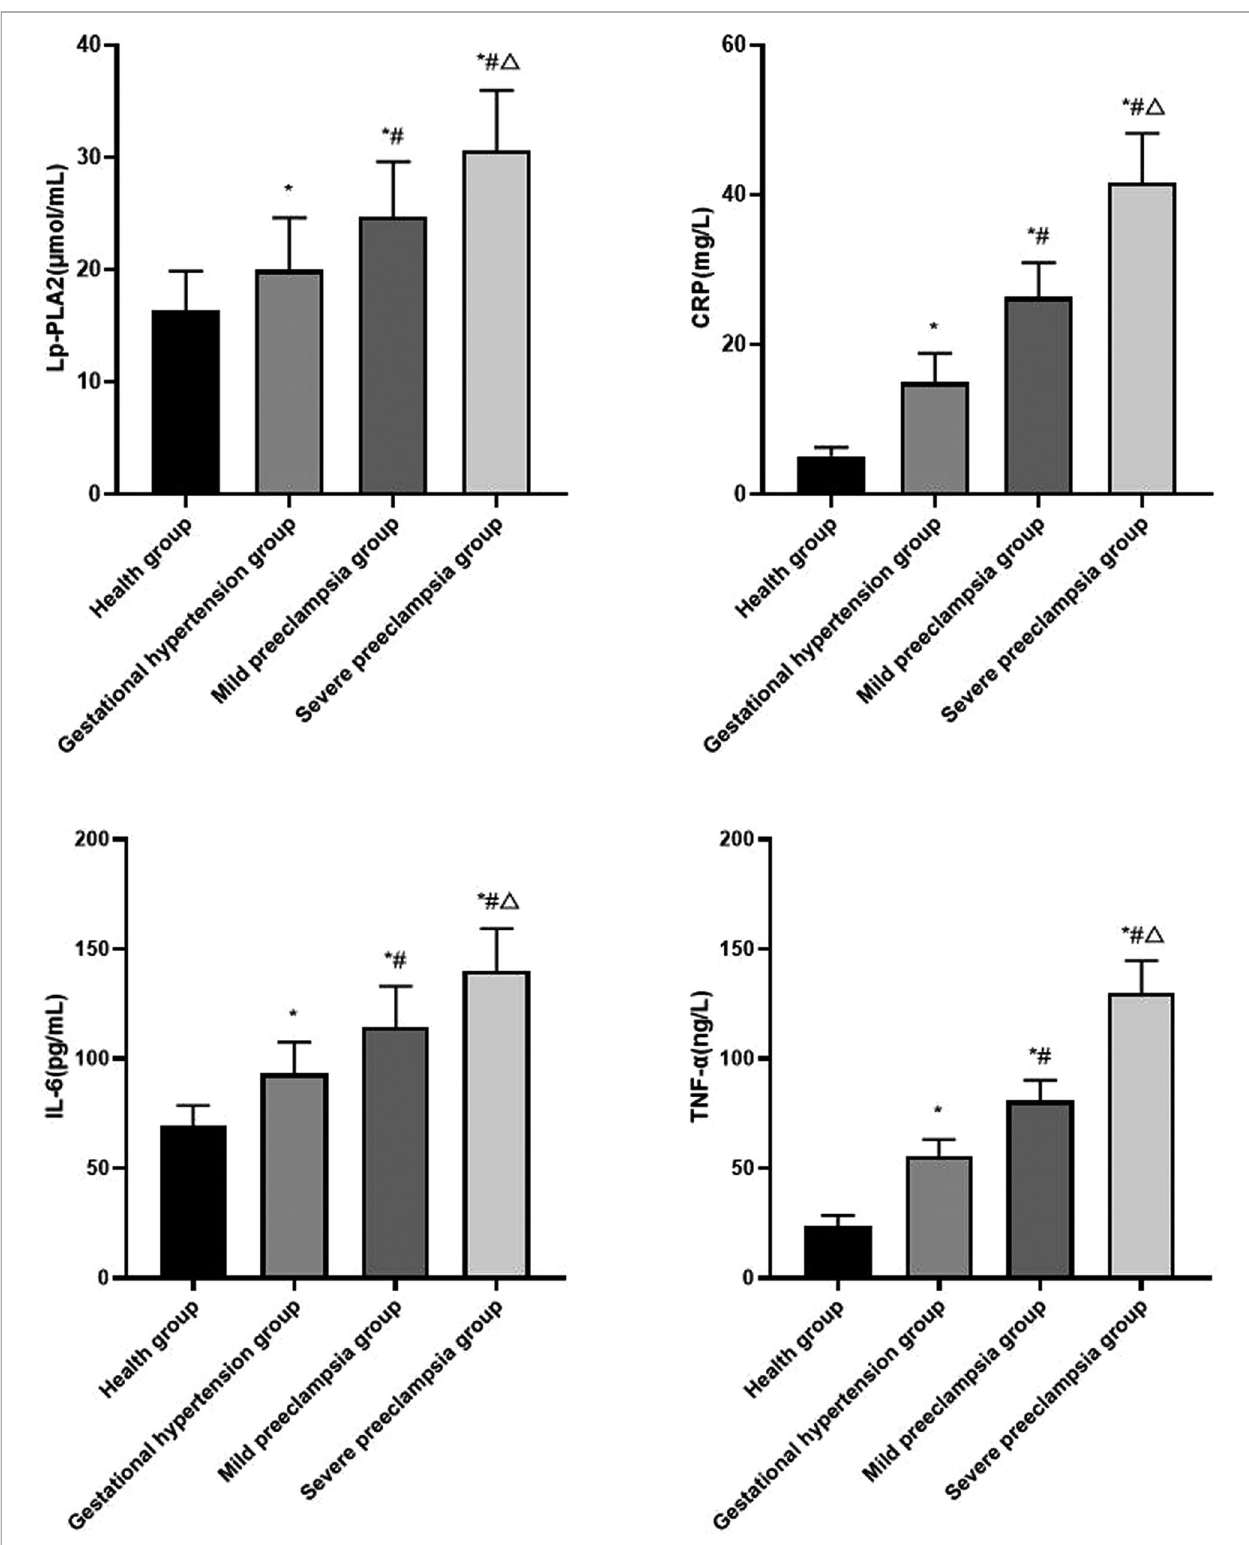
FIGURE 2 | Comparison of serum in fl ammatory factors in each group Compared with healthy group, * P <0.05; Compared with gestational hypertension group, # P <0.05; Compared with mild preeclampsia group, △ P <0.05.